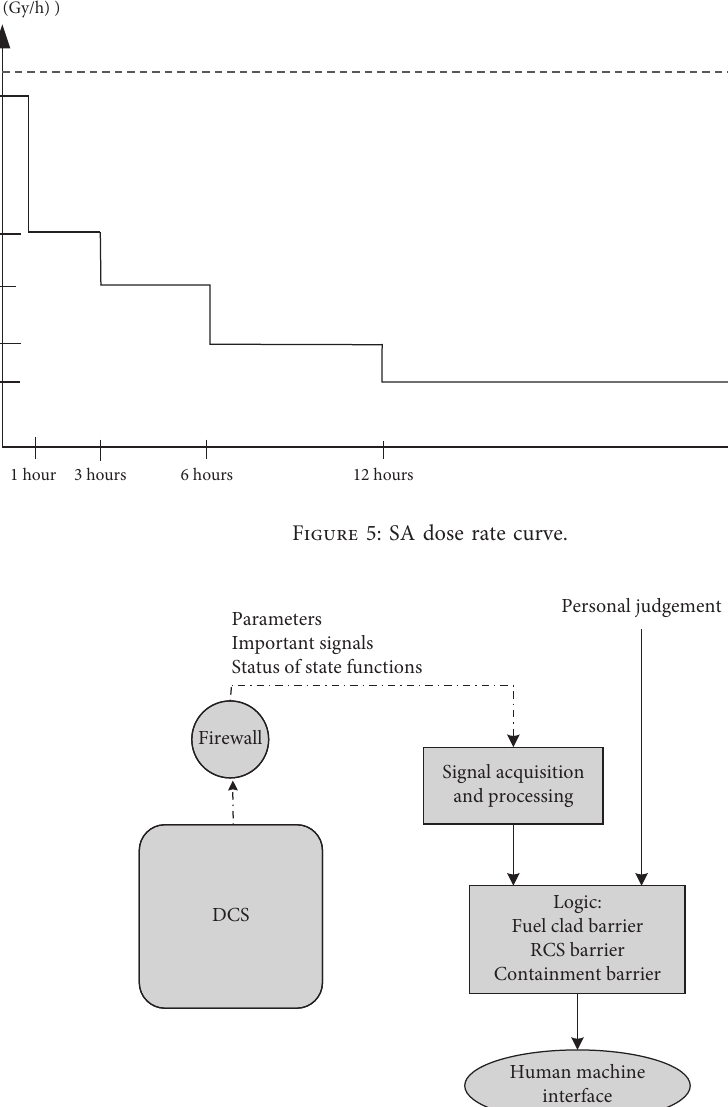
Figure 4: Containment barrier initial conditions.